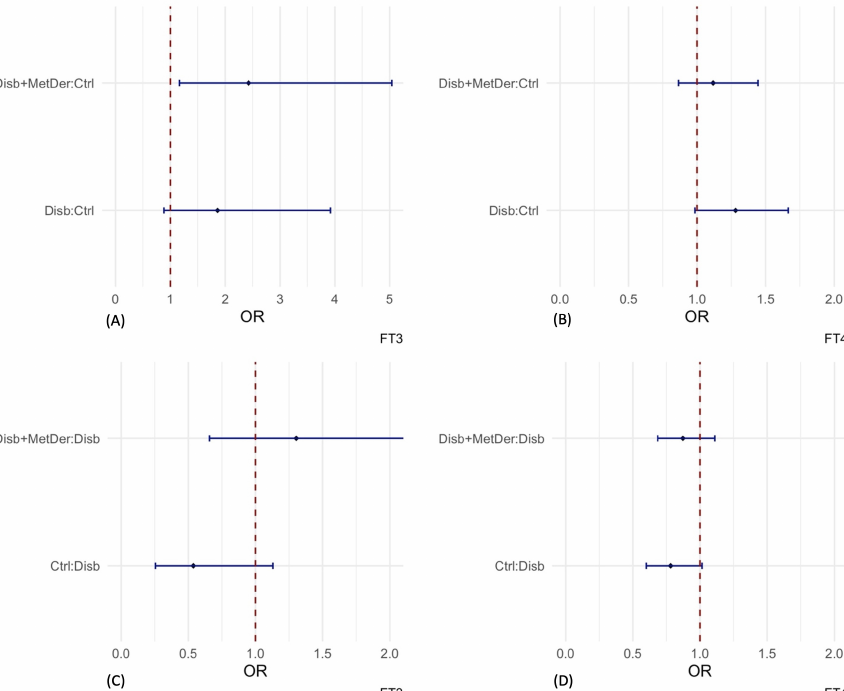
Figure A5. The figure shows the effects of FT3 and FT4 by means of the odds ratio in relation to the classes of the groups studied, when studied in the univariable multinomial logistic regression model. In ( A ), the odds ratio of being a child with disabilities and with metabolic syndrome (MS) vs. a control and the odds of being a child with disabilities without metabolic syndrome (MS) vs. a control child for an increase of 1 pmol/L of FT3; in ( B ), the odds ratio of being a child with disabilities vs. a control child and the odds of being a child with disabilities without metabolic syndrome (MS) vs. a control child for an increase of 1 pmol/L of FT4. In ( C ), the odds ratio of being a child with disabilities and MS vs. a child with neuromotor impairment and without MS, for an increase of 1 pmol/L of FT3, whereas in ( D ), the odds ratio of being a child with disabilities and MS child with neuromotor impairment without MS for an increase of 1 pmol/L of FT4.